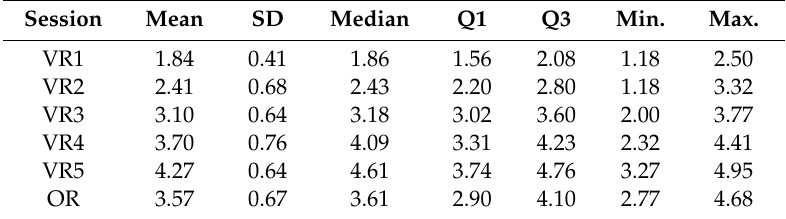
Table 1. Task-Based Checklist (TBC) results by session (VR–virtual reality surgery; OR–supervised surgery in operating room; Q1–lower quartile; Q3–upper quartile; n = 10).